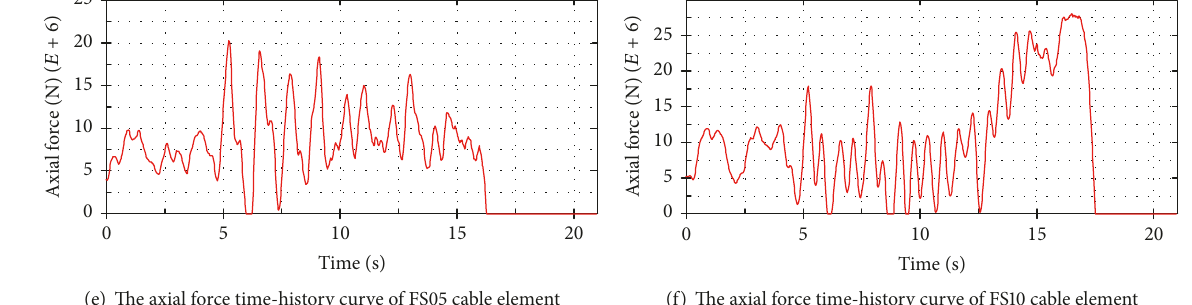
Figure 16: Time-history curves of moment and axial force for elements.